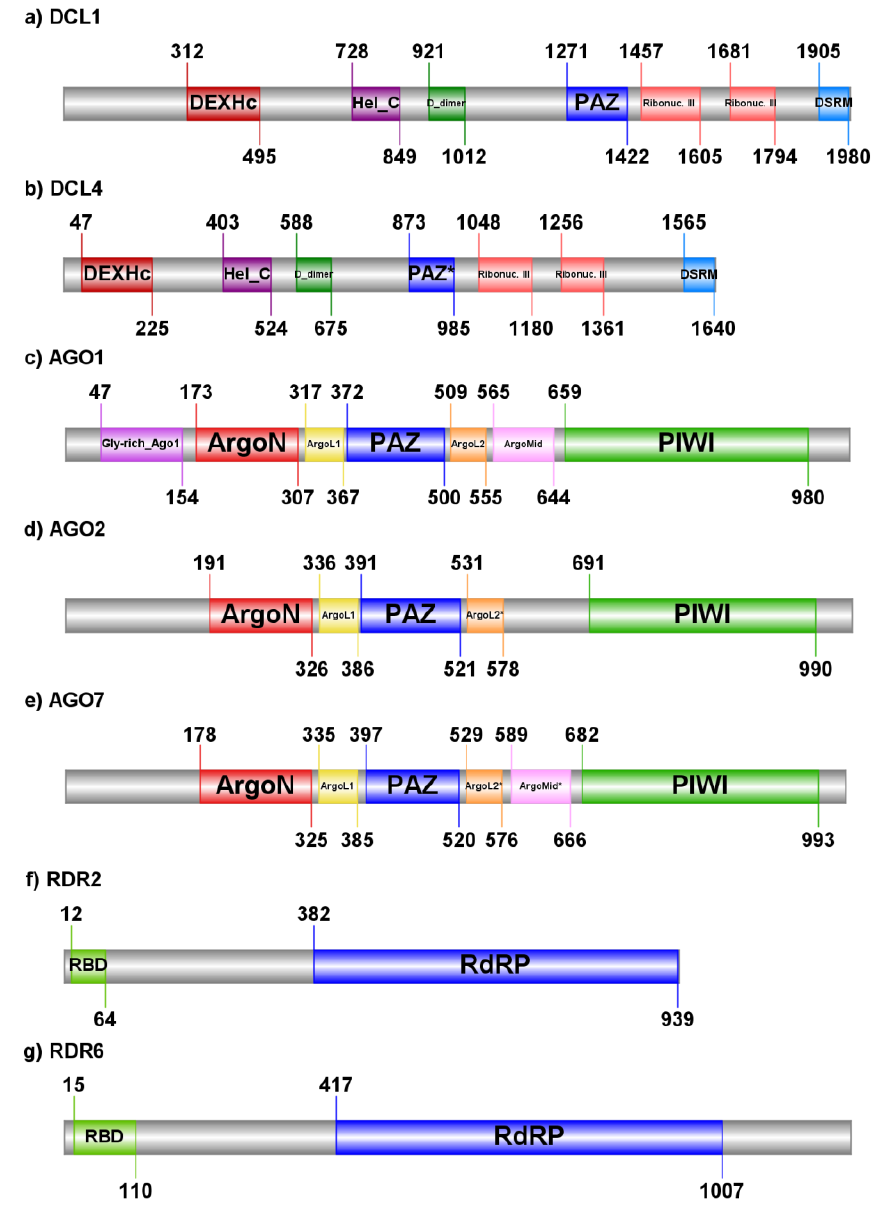
Figure 1. Protein domains identified in seven hop’s RNAi proteins. ( a , b ) Hop DCL proteins contain DEXHc-DEXH-box helicase domain of endoribonuclease Dicer at N-terminal part, Hel_C-Helicase-C domain, D_dimer-Dicer dimerisation domain, Ribonuc. III-ribonuclease III domain, and DSRM- double stranded RNA binding motif. ( c – e ) Domain analysis of AGO proteins shows the presence of Gly-rich_Ago1-Glycine-rich region of Argonaut, ArgoN-N-terminal domain of argonaute, ArgoL1- Argonaute linker 1 domain, PAZ–Piwi-Argonaute-Zwille domain, ArgoL2-Argonaute linker 2 do- main, ArgoMid-Mid domain of argonaute and PIWI–P-element induced wimpy domain. ( f , g ) RDR proteins encompass RBD–RNA binding domain and RdRP–RNA-dependent RNA polymerase. “*” in the domain name denotes domains with less significant matches to the Pfam database, but which have also been identified with Conserved Domain Database (CDD). Domains were visualized with the online tool “llustrator of Biological Sequences” (IBS; http://ibs.biocuckoo.org/online.php; accessed on 16 April